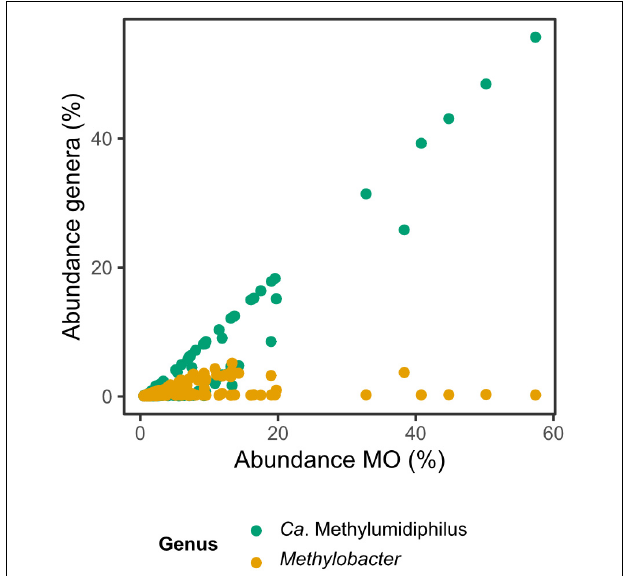
FIGURE 4 | Relative abundances of the most abundant methanotrophic taxa in the function of the total relative abundance of methanotrophs (MO). The two most abundant taxa of MO are plotted against the total abundance of MO. The Spearman’s rank correlation coefficient is 0.96 for Candidatus Methylumidiphilus and 0.27 for Methylobacter . Each sample is represented by two points, one for each